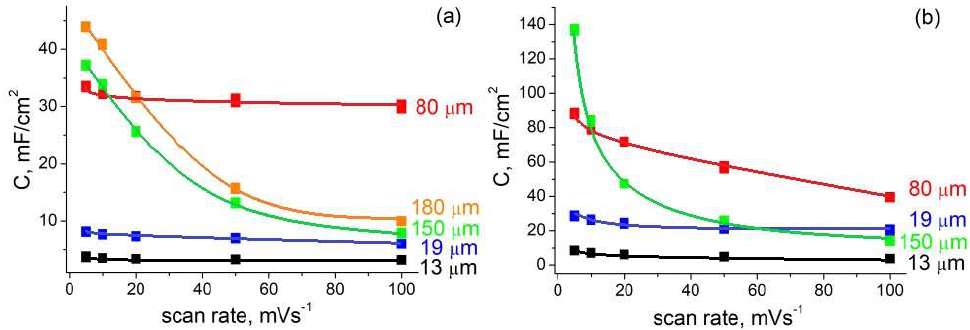
Figure 4. Scan rate dependence of the area-normalized capacitance at different depth of porous layer for the por-Si samples with ( b ) and without ( a ) GLC.